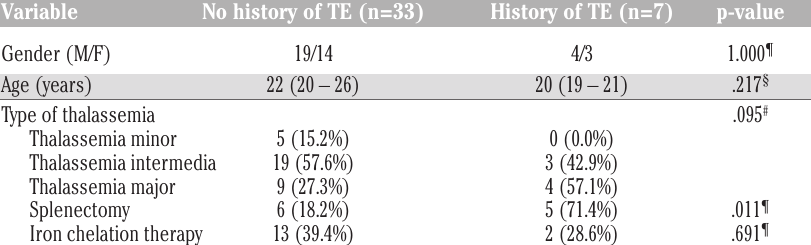
Table 3. Correlation between demographic and clinical variables and the development of thrombotic events in thalassemic patients. Variable